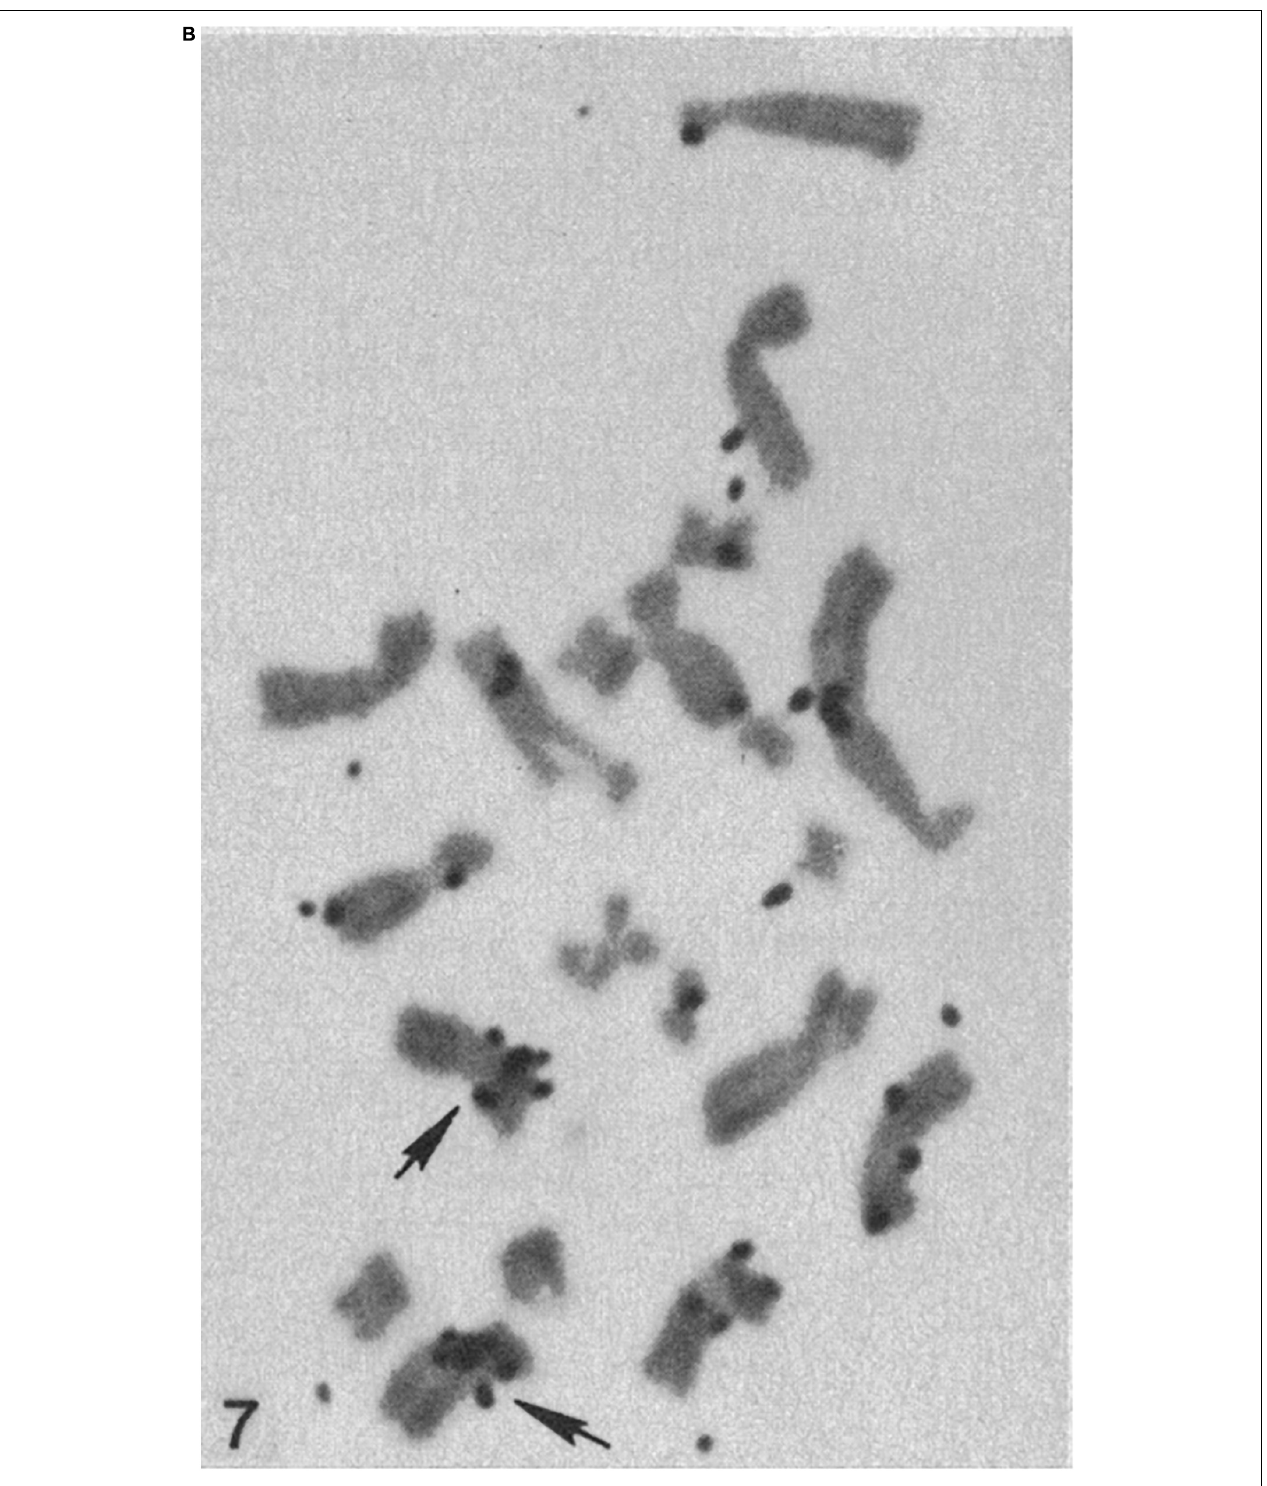
FIGURE 7B | Chromosomes from hypotonic lysed tetraploid PTK2 cell clones subjected to H 3 -thymidine ribosomal RNA-DNA hybridization. The original parent cell of the cell in panel (A) had one NOR region ablated in mitotic pro-metaphase. The chromosome spread in panel (B) is from a control cell population that received no laser ablation. The cluster of autoradiography silver grains on a chromosome denotes the r-DNA NOR. The control tetraploid cell has two X-chromosomes, each with a cluster of grains at the cytologic location of the rDNA NOR, whereas the cell cloned from the laser-irradiated cell, has a cluster of silver grain only on one of the X-chromosomes, indicating that one NOR rDNA region has been deleted (arrows indicate the X-chromosomes; after Berns et al., 1979, 1981).